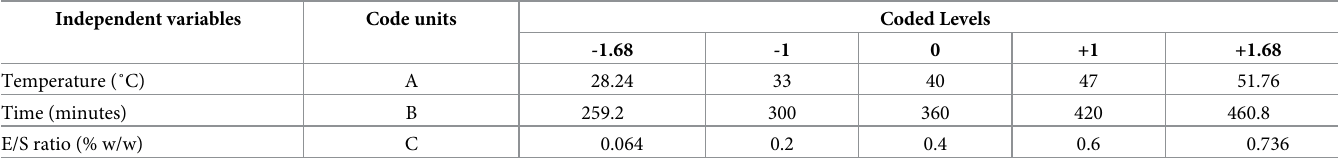
Table 2. Independent variables and code levels for the SBPH based on CCD.